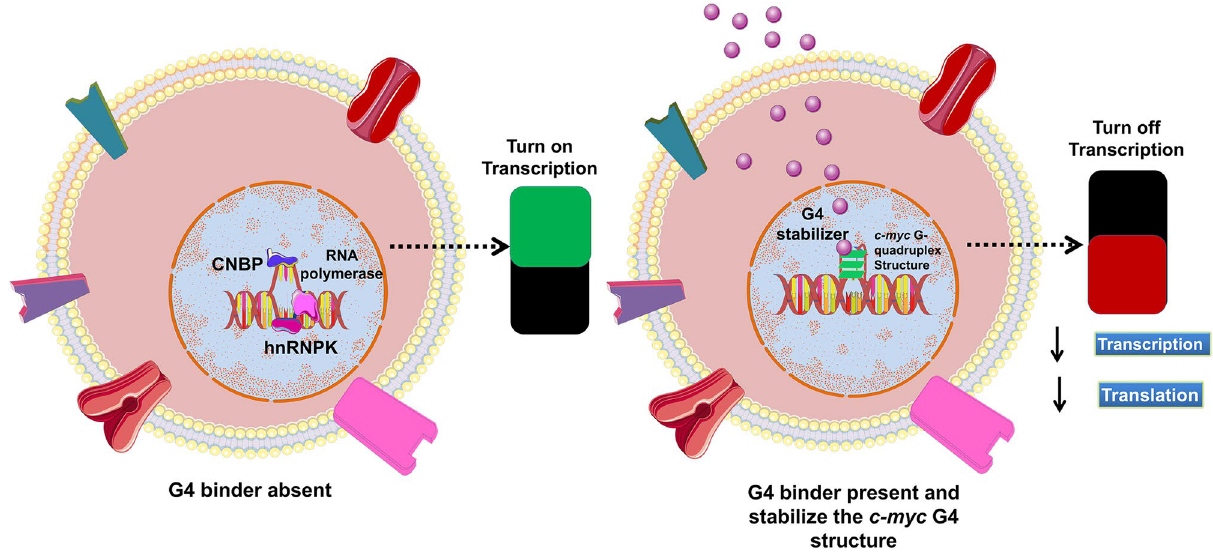
Figure 1. Schematic representation related to the influence of c-myc gene expression in the absence and presence of G4